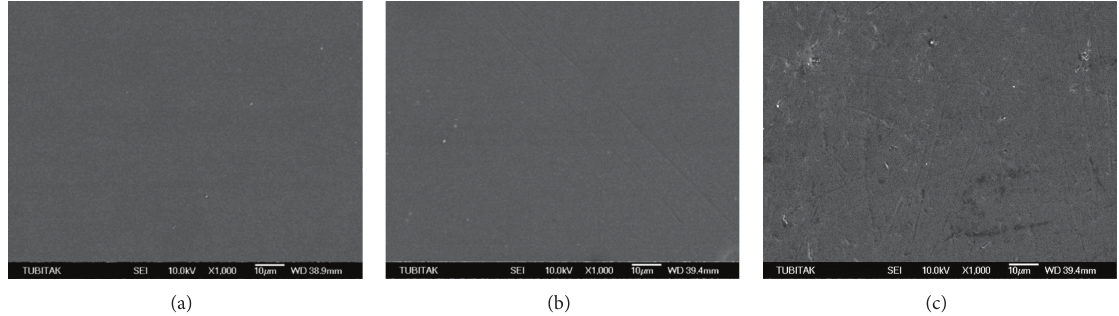
Figure 4: (a) Scanning electron micrograph of GE2-C group showed a homogeneous surface. (b) GE2-DT showed some slight scratch lines while (c) GE2-TP revealed some defects and